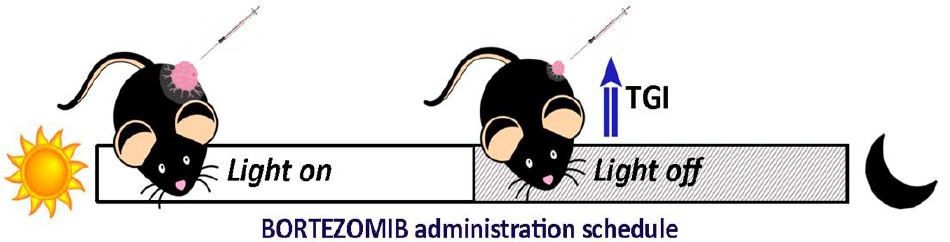
Figure 2. Tumor growth inhibition (TGI) of glioma xenografts by chrono-chemotherapy using Bortezomib. C57BL/6 mice maintained in regular L/D cycles were injected with a cell line isolated from a malignant peripheral nerve sheath tumor generated in NPcis mice. Once the tumor was palpable, mice were randomly separated, and Bortezomib (0.5 mg/kg) or the vehicle, were administered at the beginning of the day or night. Tumor growth and animal weight were measured periodically. TGI of 70% and 18% was observed when Bortezomib was administered at the beginning of the night or the day, respectively [21].